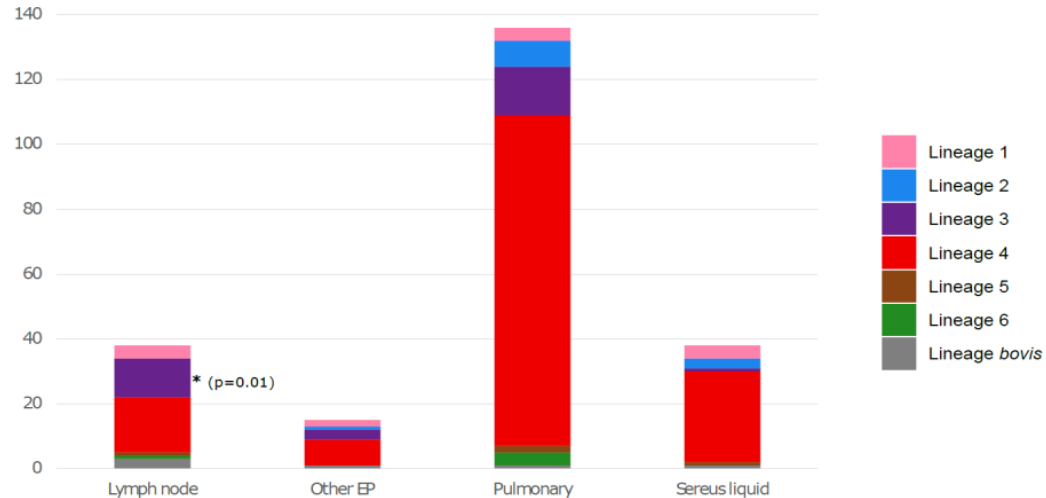
Figure 3. Distribution of M. tuberculosis lineages according to the origin of the sample. EP: extrapulmonary. The asterisk correspond the significative association between the East-African-Indian lineage 3 and lymph node TB.